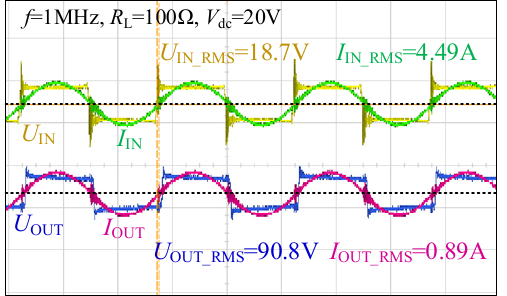
Figure 16. Experimental waveforms of U IN , I IN , U OUT , and I OUT .